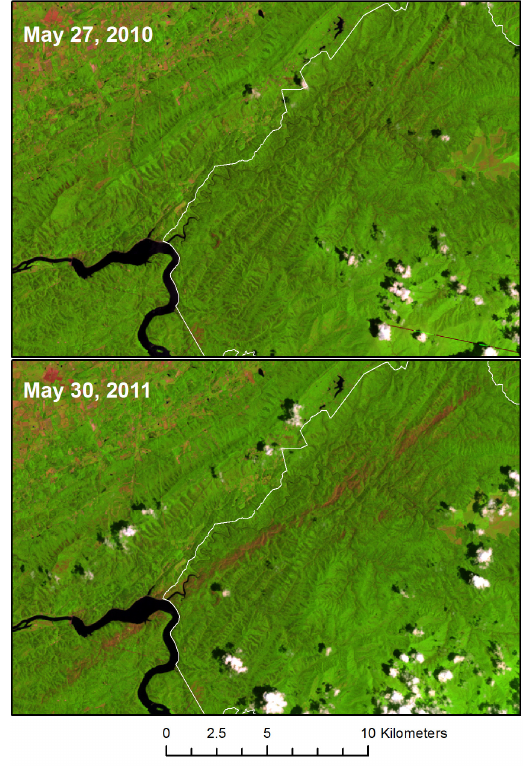
Figure 2: Landsat 5 TM color composites showing the area affected by the April 27, 2011 tornado in the Great Smoky Mountains National Park: image acquired on May 27, 2010 showing no extreme wind damage (top) and image acquired on May 30, 2011 showing a southwest-northeast tornado track (bottom). Western park boundary is shown as a white line. The spatial distribution of disturbance intensity due to extreme winds was investigated by using anomalies of the Enhanced Vegetation Index ( Δ EVI = EVI2011-EVI2010) (Figure 3).